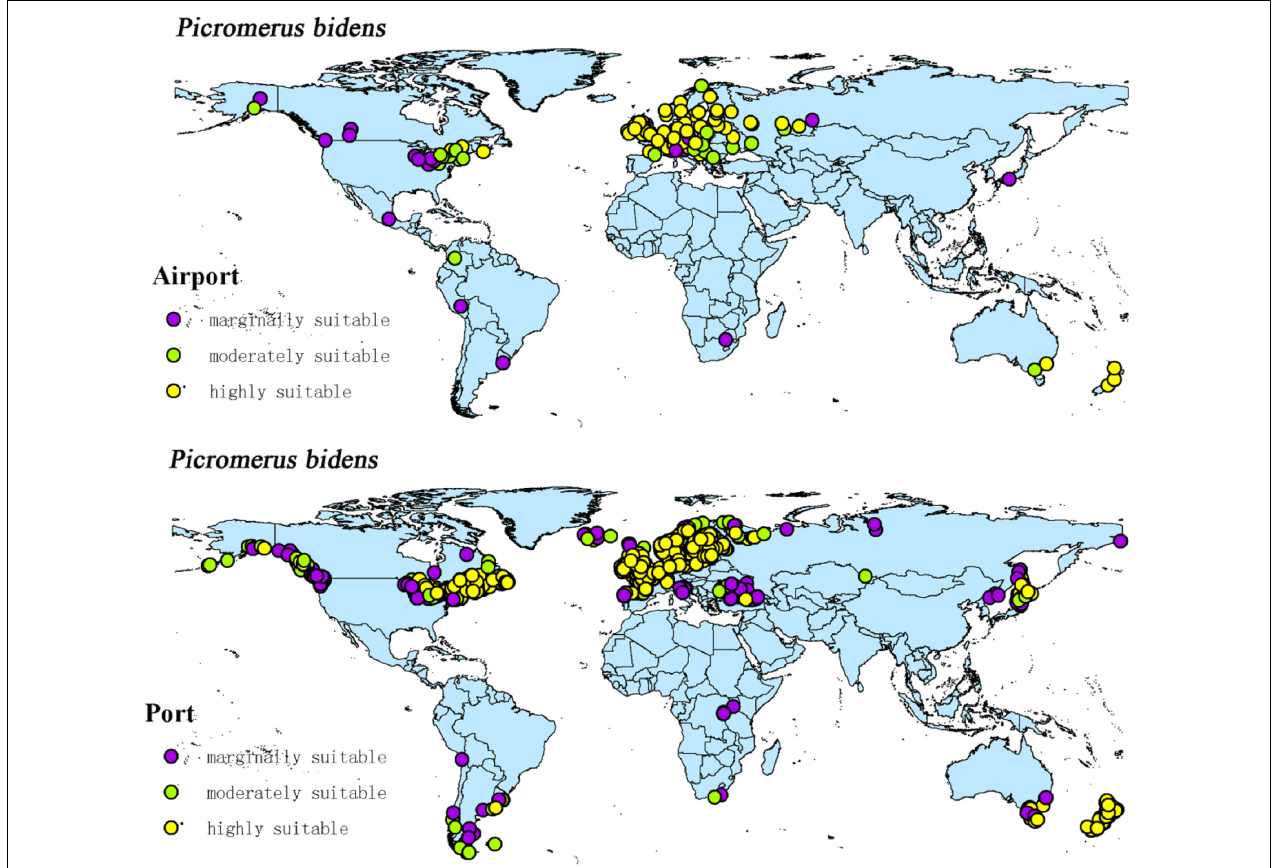
FIGURE 11 | Global large airports and ports within the suitable of P. bidens .